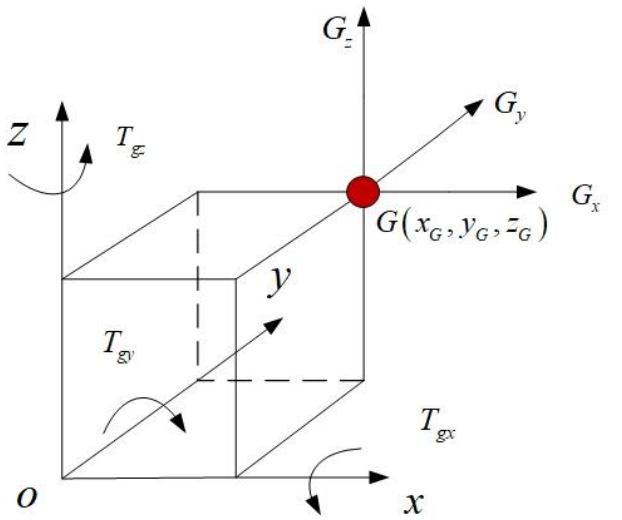
Figure A3. The torque exerted by gravitational load on the end effector of the humanoid manipu- lator.